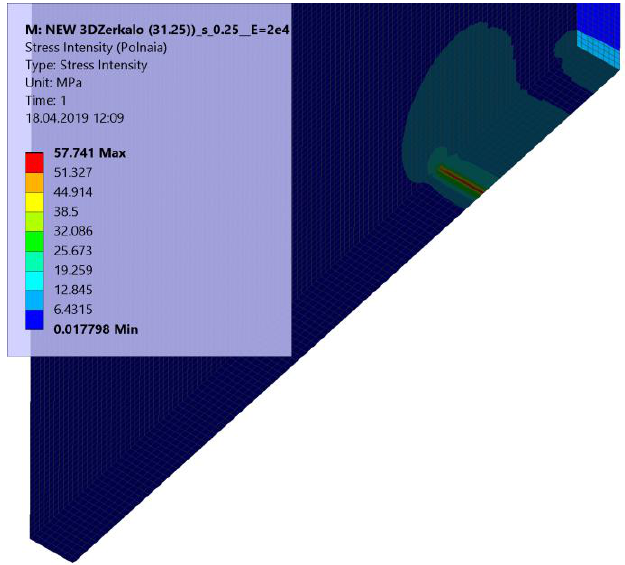
Fig. 7. Distribution of stress intensity σ i in the lower part of the deep beam